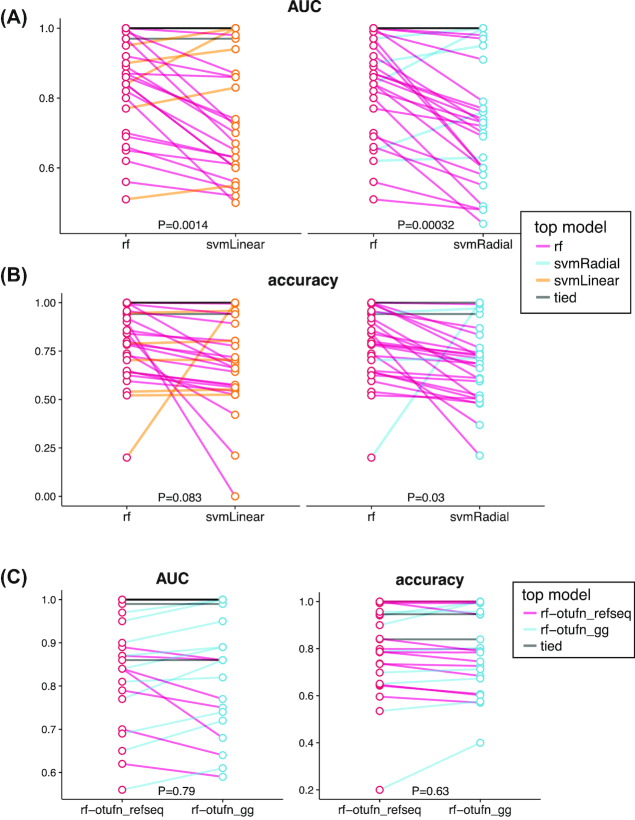
Summary statistics of framework and database comparisons. (A) AUCs of random forest (rf) to SVM-Linear (left) and random forest to SVM-Radial (right). Paired t-tests reveal that random forest results in significantly higher AUC than both SVM-Linear (P = 0.0014) and SVM-Radial (P = 0.00032). (B) Accuracies of random forest to SVM-Linear (left) and random forest to SVM-Radial (right). Paired t-tests reveal that random forest results in significantly better accuracy than SVM-Radial (P = 0.03), but not SVM-Linear (P = 0.083). (C) AUCs (left) and accuracies (right) of random forest classifications of 24 tasks using OTUs picked with NCBI RefSeq database or Greengenes (gg) database as predictors. Student t-test reveals that reference database choice has limited impact on classification AUC or accuracy. Lines are colored by the top model for each classification task.